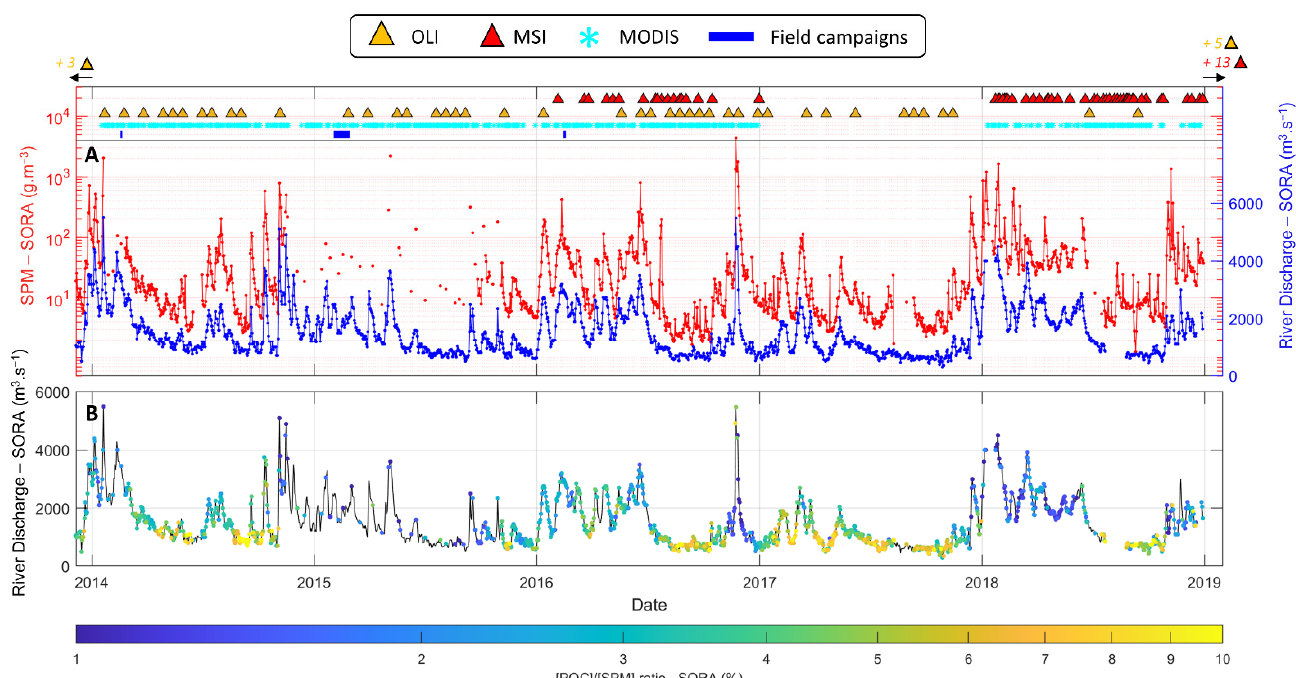
Figure 2. ( A ) Daily averaged in situ SPM concentration and river discharge measured at the SORA station (Arles) from 2014 to 2018. Days with cloud-free OLI (yellow triangles), MSI (red triangles), and MODIS (cyan asterisks) satellite data are indicated in the top part of the panel. The number of additional OLI and MSI images in 2013 and 2019–2020 are indicated in the top left and right corners, respectively. The field campaign periods with SPM and radiometric measurements are also indicated (blue line). ( B ) POC-SPM ratio (colored points) measured at the SORA station overlapping the Rhône River discharge (black line).